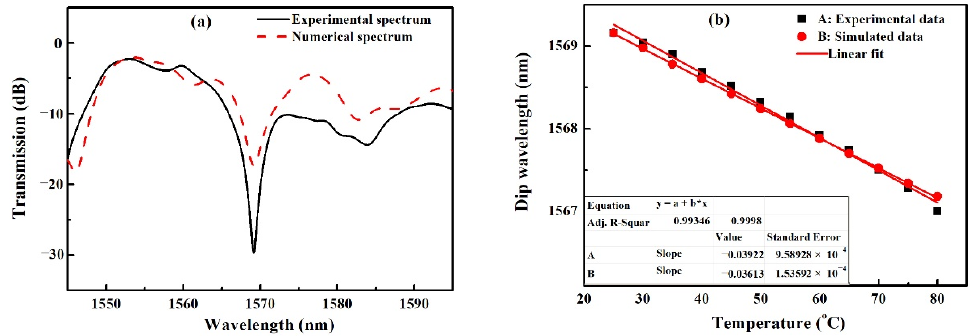
Figure 4. Compare of the numerical and experimental results: ( a ) Transmission spectra at 25 °C; ( b ) Variation of dip wavelength of the spectrum with the temperature.